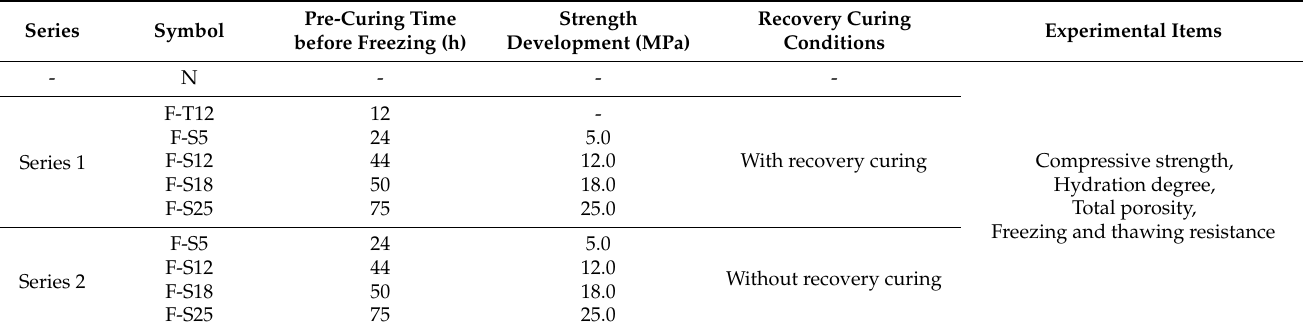
Table 5. Experimental design of the main